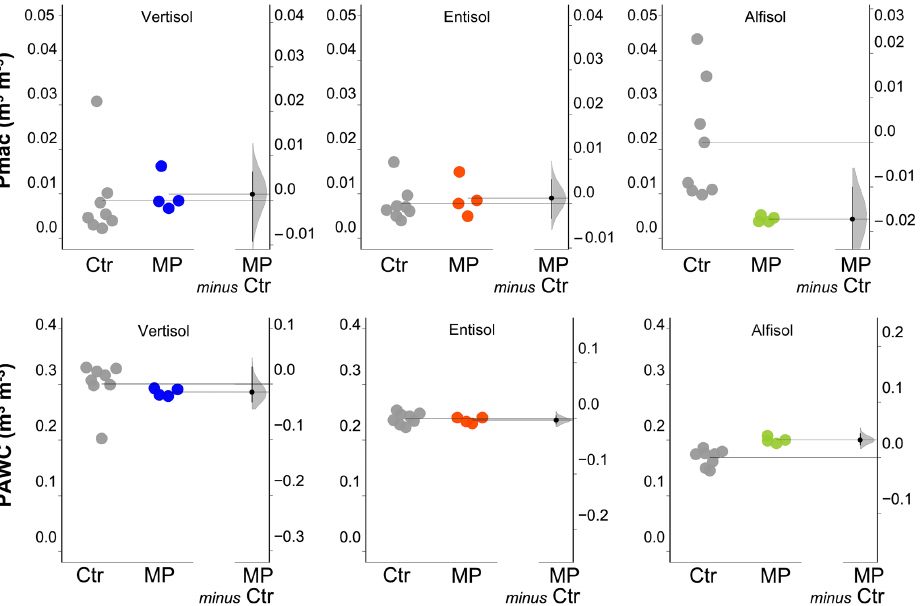
Figure 4. Soil macroporosity index ( P mac ) and plant-available water content (PAWC). Raw data of the control (Ctr, gray dots) and polyester MP fibers added to the treatment (MP, colored dots) are shown in the plot for each soil. The filled curve indicates the resampled distribution of the mean differences ( (cid:49) ), given the observed data. Horizontally aligned with the mean of the test group, (cid:49) is indicated by the black circle. The 95% confidence interval of (cid:49) is illustrated by the black vertical